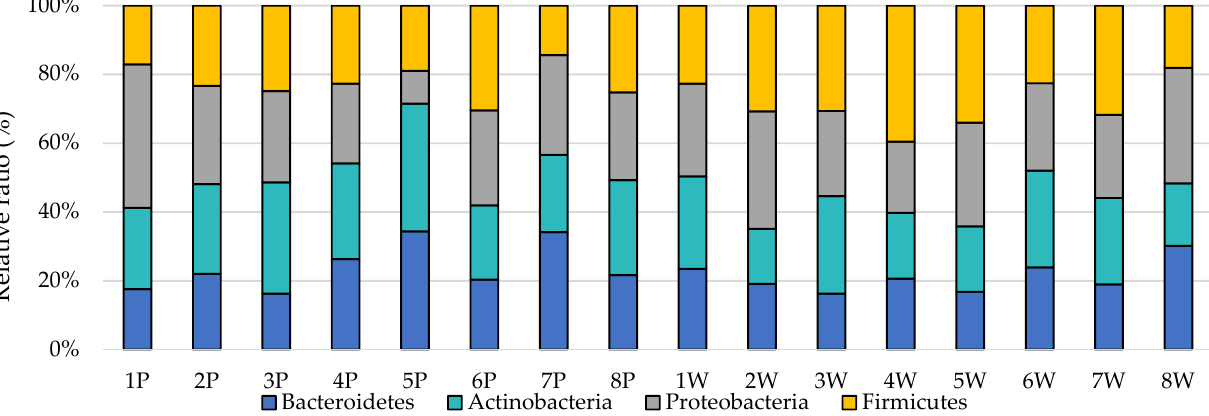
Figure 2. Relative ratio (%) of the chosen bacteria phyla in individual animals (P—primiparous, W—multiparous).